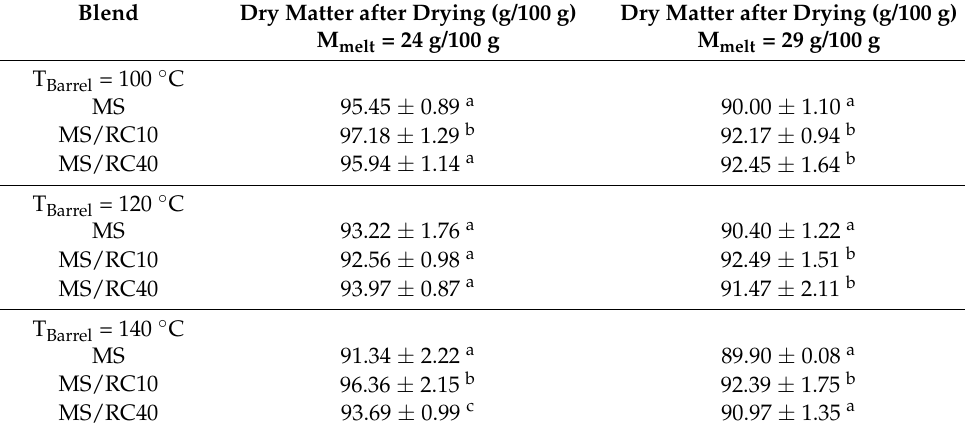
Table 3. Effect of barrel temperature (T Barrel = 100, 120, 140 ◦ C) and the addition of rapeseed press cake (RPC) (0, 10, 40 g/100 g (w.b.)) to maize starch (MS) extruded at 24 or 29 g/100 g (d.m.) moisture content on dry matter content (g/100 g) after drying extrudates for 24 h at 40 ◦ C. Blend Dry Matter after Drying (g/100 g)